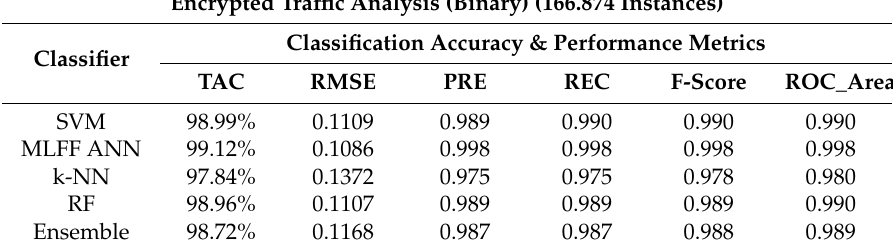
Table 3. Comparison between algorithms.